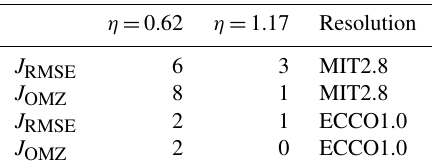
Table 3. Number of simulations with different parameters for D L , α and w 1 for the porous ( η = 0 . 62) and dense ( η = 1 . 17) particles which outperform the corresponding other size. The numbers are given with respect to two different criteria, J RMSE and J OMZ